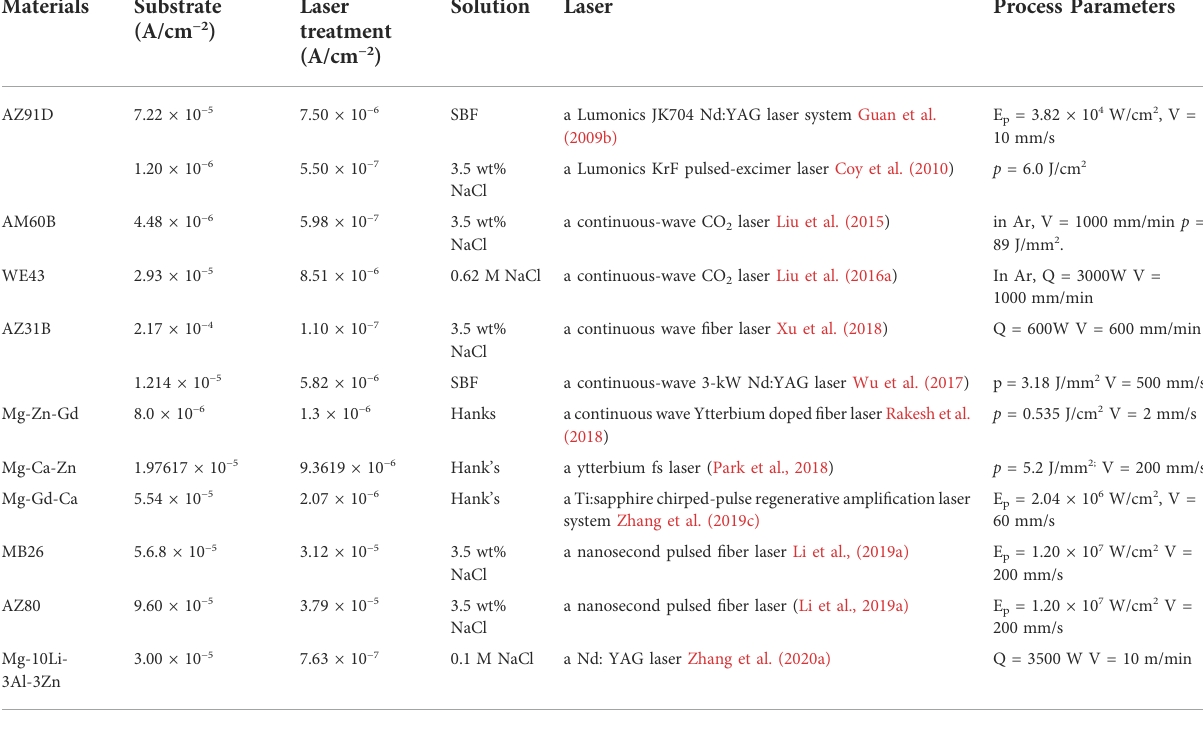
TABLE 3 Comparison of corrosion rate in different solutions after laser treatment.